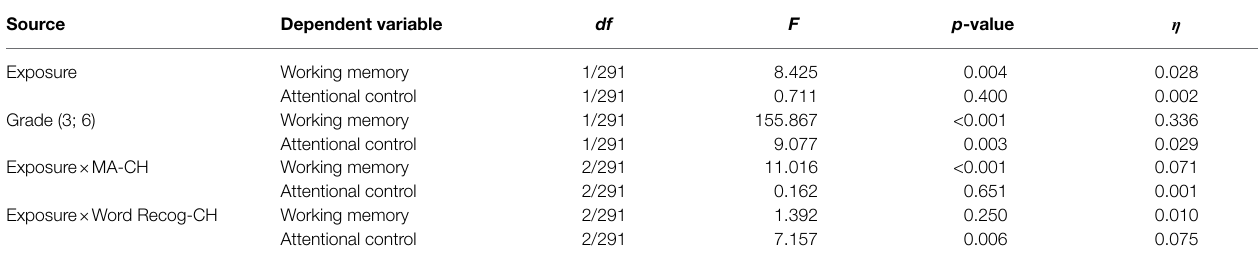
TABLE 4 | Significant multivariate main effects and interaction of exposure (early/late) to English and grade on working memory and attentional control (at p < 0.001 level). Source